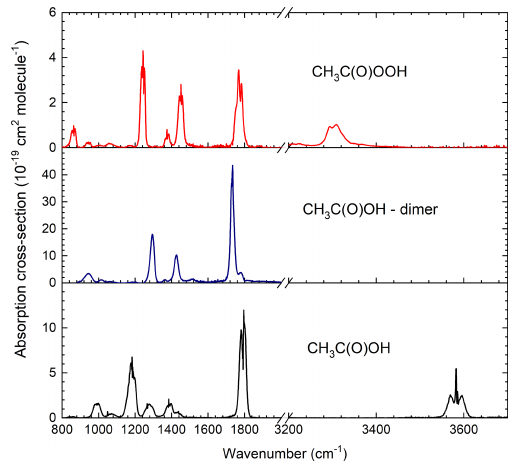
Figure 2. IR absorption cross-sections (base e) obtained in the long- path absorption cell. A comparison of the CH 3 C(O)OOH spectrum with the literature is given in Fig.